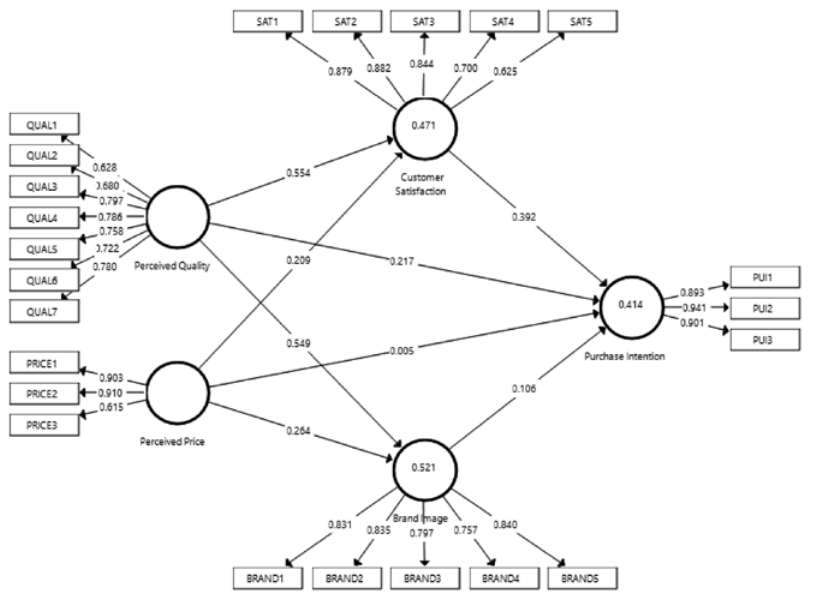
Source: own elaboration in SmartPLS